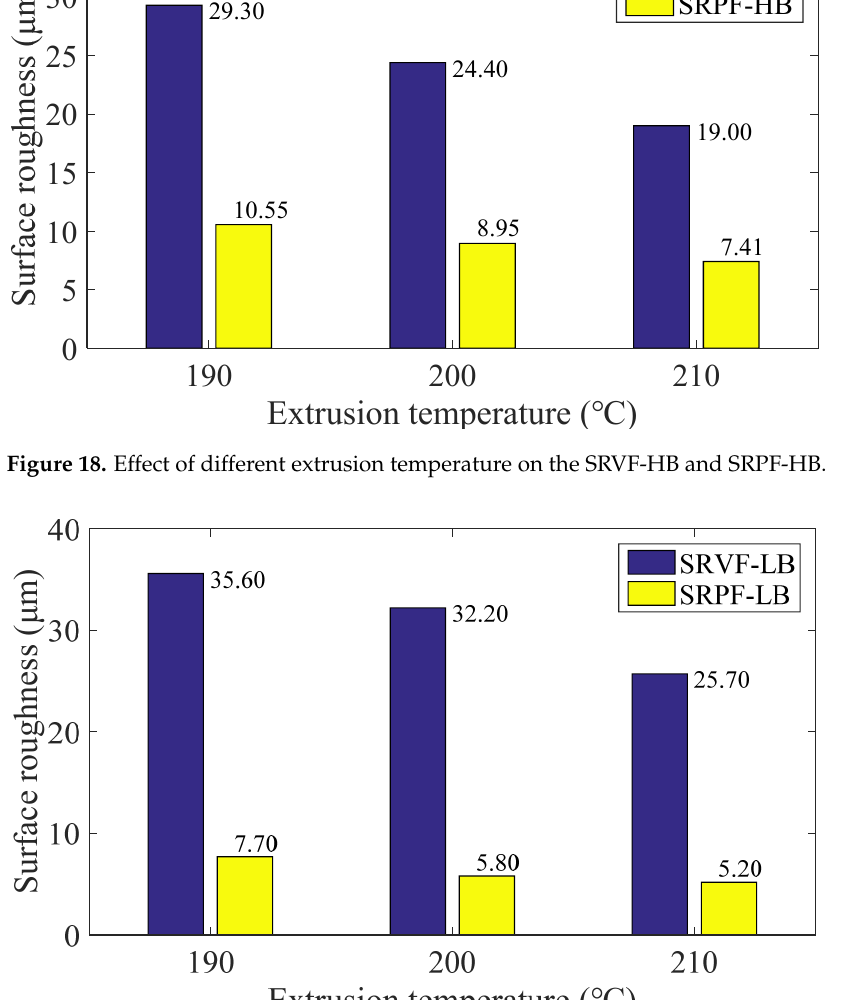
Figure 19. Effect of different extrusion temperature on the SRVF-LB and SRPF-LB.